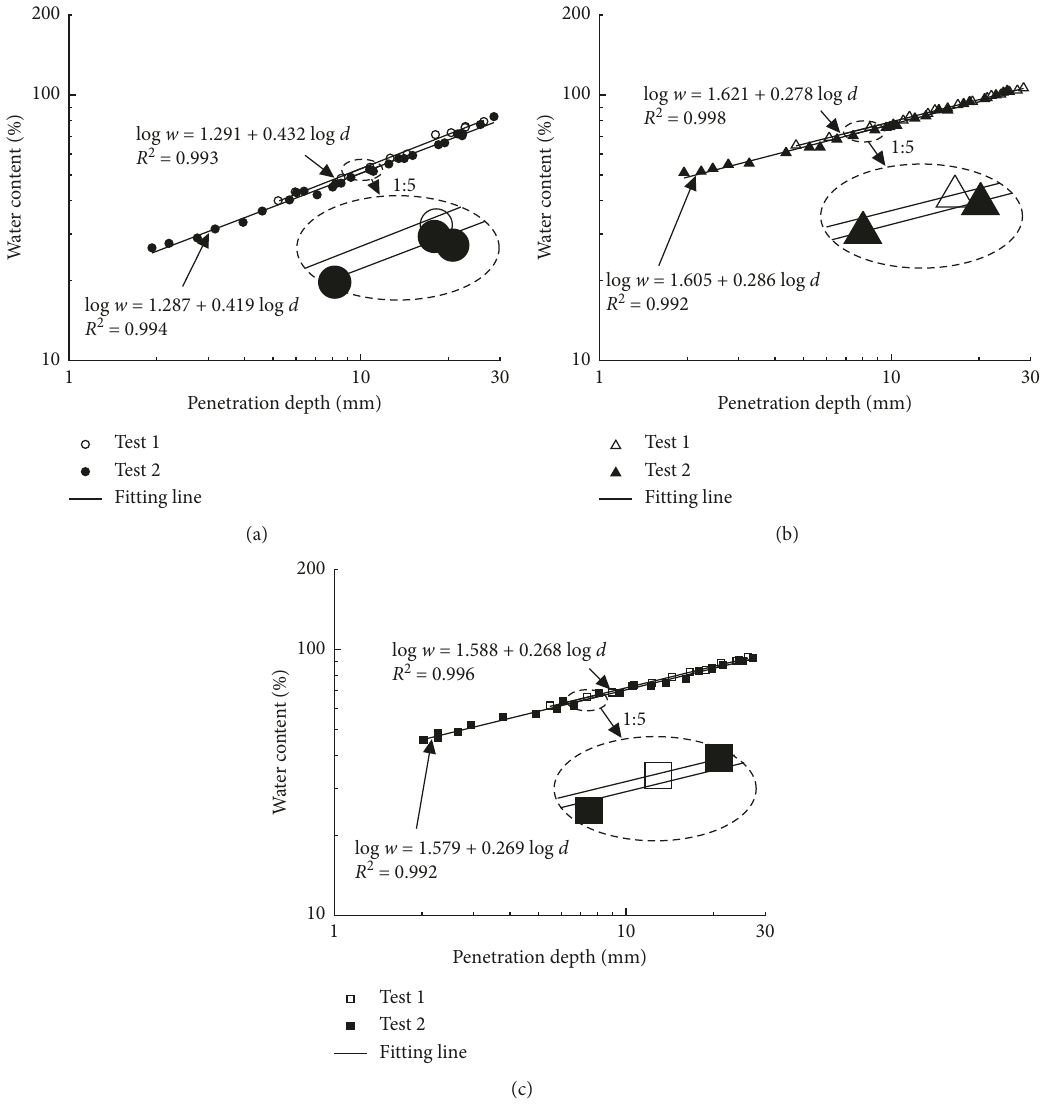
Figure 2: Relationship between penetration depth and water content. (a) Kaolin. (b) Bentonite. (c) 50% kaolin and 50%